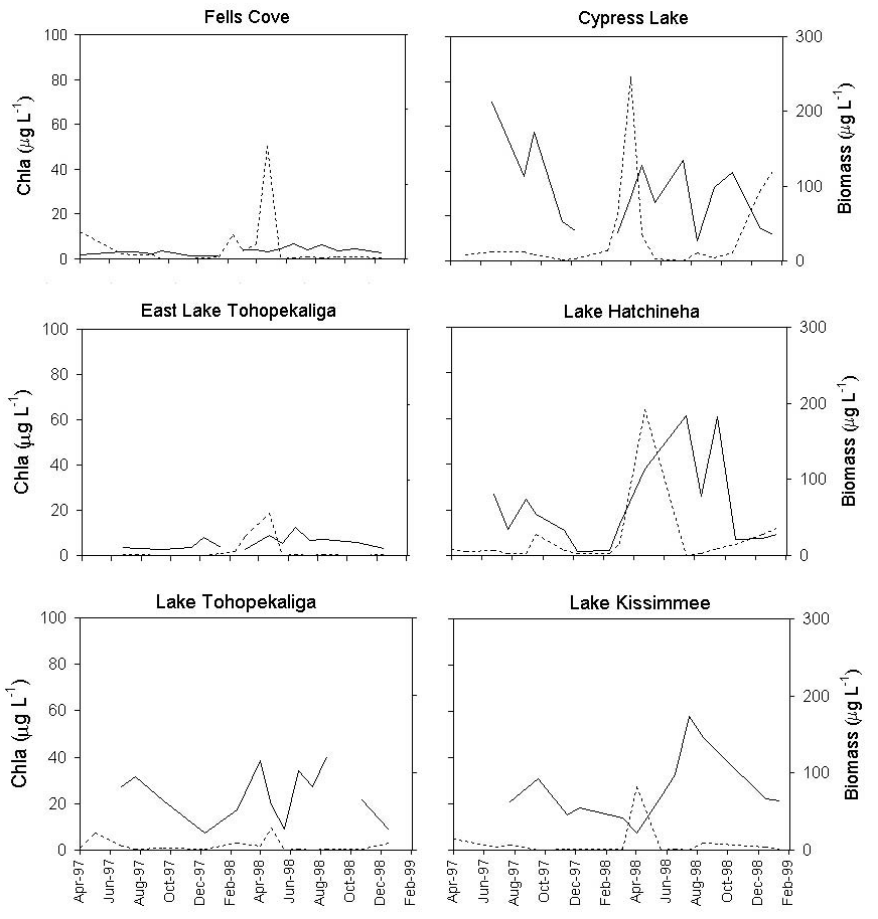
FIGURE 6. Near-surface concentrations of chlorophyll a (SOLID LINE, Chl a) and total community biomass of macro-zooplankton (DASHED LINE) in the Kissimmee Chain-of-Lakes during 1997 and 1998. The lack of significant negative relationships between Chl α and zooplankton biomass is consistent with a hypothesis that zooplankton grazing has little influence on phytoplankton biomass. It is consistent with results from zooplankton exclosure studies on nearby Lake Okeechobee, where a substantial reduction in macro-zooplankton did not result in significant increases in Chl α inside experimental enclosures[14]. In contrast, there is evidence that phytoplankton are controlled by nutrient availability, based on the significant positive relationships between Chl α and TP in five of the six lakes and across lakes for the lake-averaged data. Similarly, Chl a increases were documented where nutrients were added to enclosures in Lake Okeechobee, as long as the light climate was sufficient for net algal growth[14,20]. The Kissimmee Chain-of-Lakes are more likely to be nutrient limited than Lake Okeechobee, because they are not affected by the high levels of abiotic turbidity that often occur in the larger lake system. With the exception of high levels of organic color in Fells Cove and East Lake Tohopekaliga, most of the underwater light attenuation in the Kissimmee lakes appears to be due to plankton (Havens, unpublished analysis of Chl α vs. Secchi relationships). In contrast, light attenuation in Lake Okeechobee is strongly controlled by abiotic